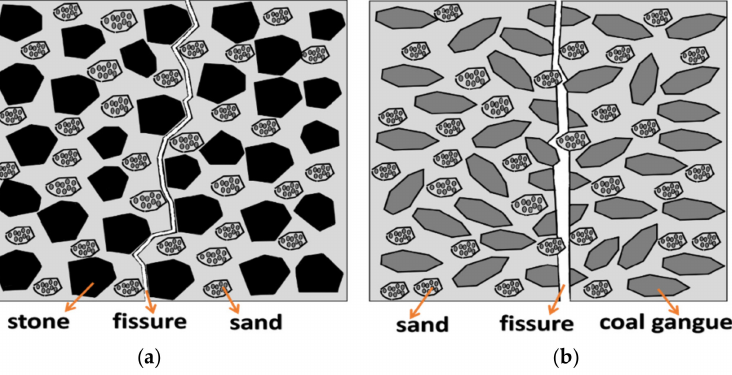
Figure 10. Failure trend of concrete: ( a ) Normal concrete; ( b ) Coal gangue concrete.